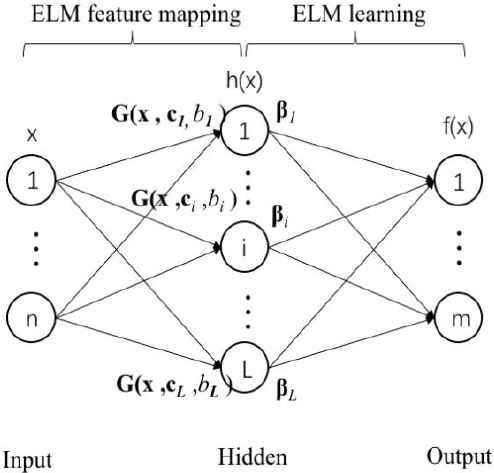
Figure 4. Flowchart of the ELM algorithm.